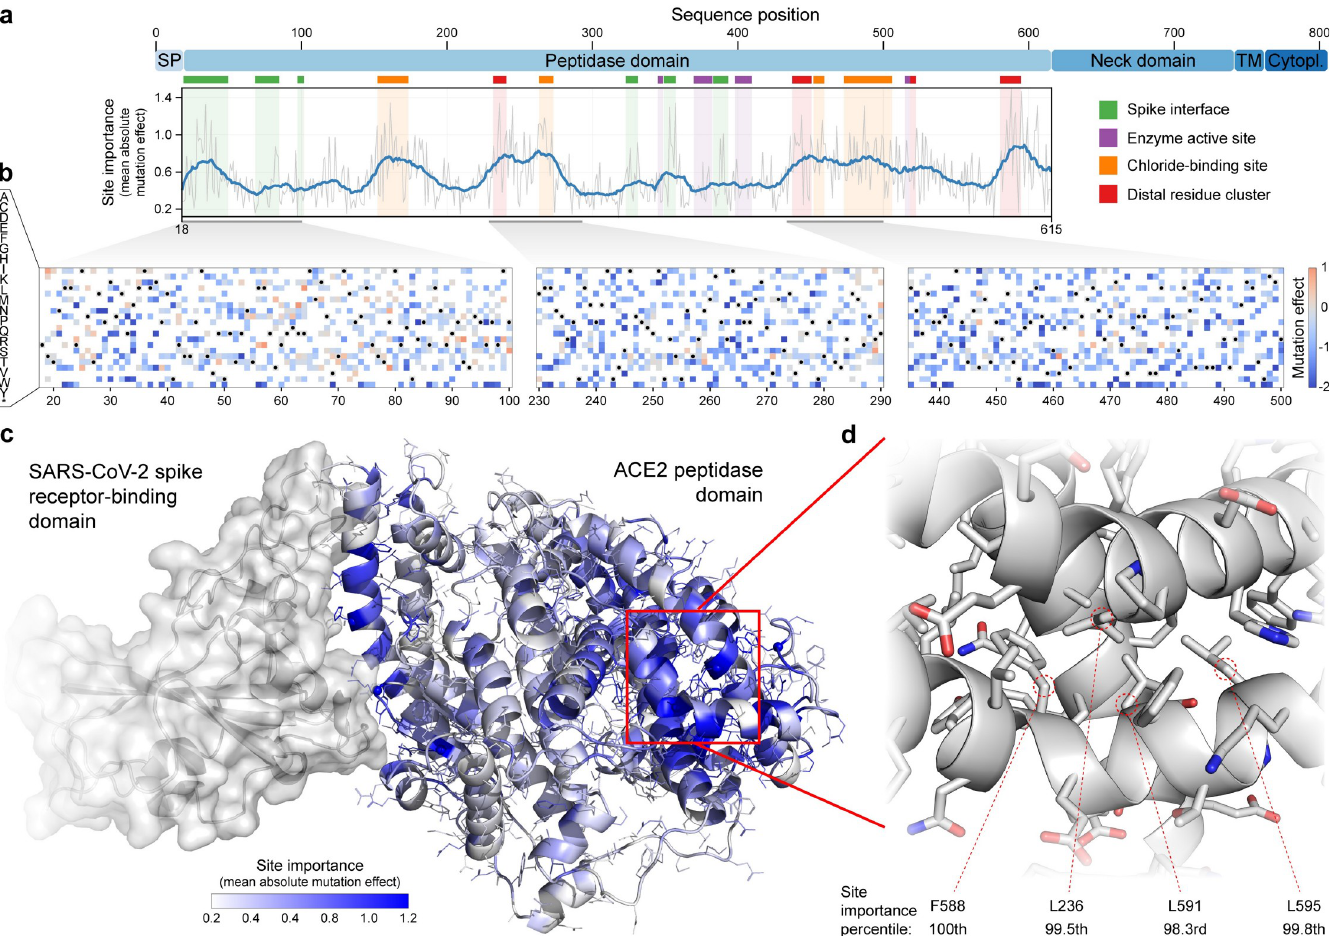
Fig 1. Large-scale mutagenesis of ACE2’s peptidase domain. (a) Analysis of how amino acid substitutions across positions 18–615 affect binding of the SARS-CoV-2 spike protein. The plot quantifies the importance of each site by taking the mean of the absolute value of all mutation effects observed at that site. The grey line represents the mean absolute value of the mutation effect and the blue line shows the moving average to highlight general regions of ACE2 that are important for binding. Key structural landmarks are highlighted with shaded regions along the length of the sequence. (b) Mutation effect heat maps for three different regions of ACE2. Red denotes mutations that increase ACE2 spike binding; blue denotes reduced binding. Overall, we observe the effects of 3571 amino acid substitutions across 597 positions in ACE2’s peptidase domain. (c) The mean absolute mutation effect mapped onto the three-dimensional ACE2 structure (PDB ID: 6LZG). Residues near the spike interface are important for binding, in addition to many sites located on the distal lobe of the protein domain. (d) The most important region of ACE2 structure is composed of a tightly packed cluster of residues located over 30 Å from the spike interface.